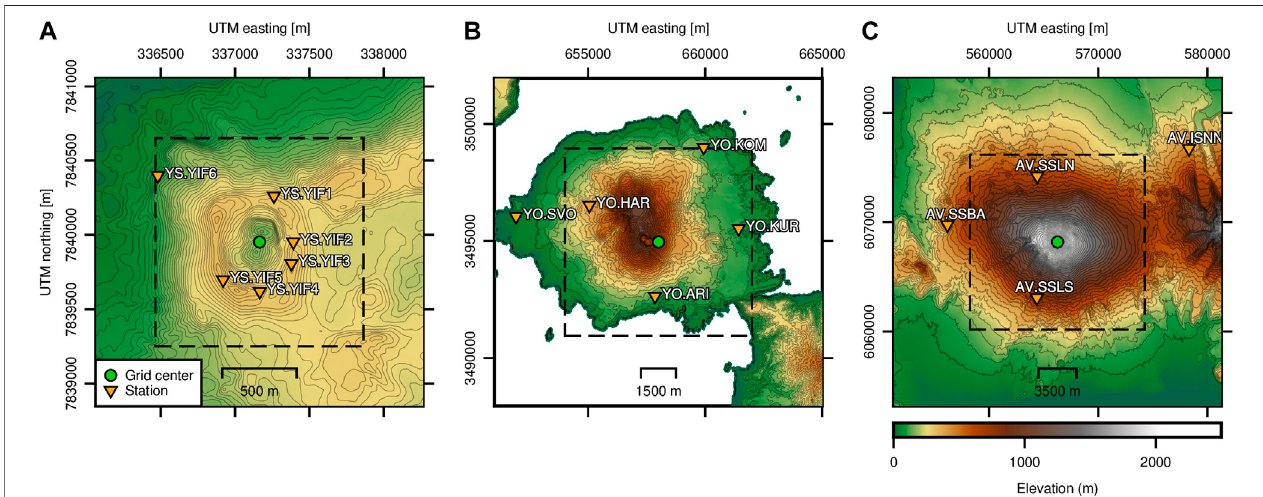
FIGURE 1 | Topographic maps and network layouts of the three study areas. (A) Yasur Volcano, Vanuatu; (B) Sakurajima Volcano, Japan; and (C) Shishaldin Volcano, Alaska. Black dashed box outlines the respective RTM search grids. Infrasound and seismic stations used in this study are indicated by inverted orange triangles, and the green circle denotes the grid centers. Note the x - and y -scales are different but elevation scales are the same between the